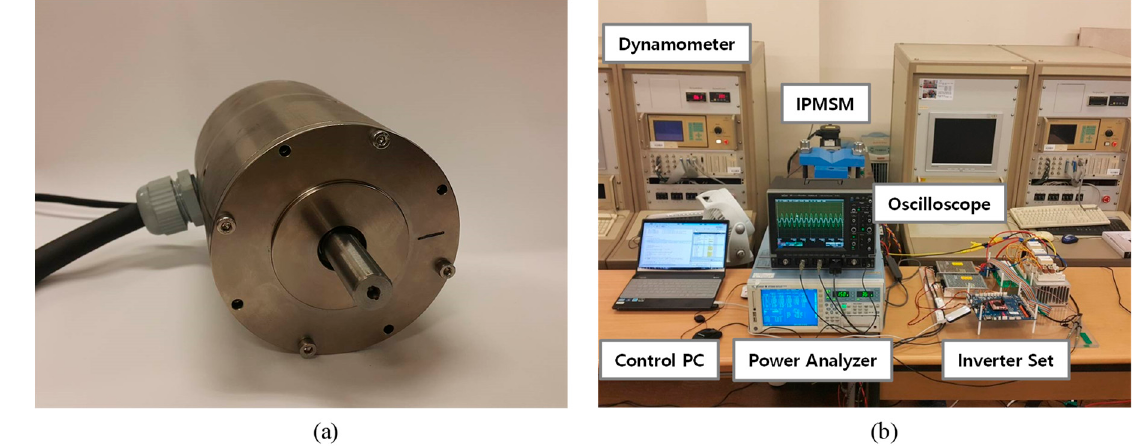
Figure 15. Experimental setup for IPMSM control: ( a ) IPMSM for the experiments; ( b ) experimental setup.